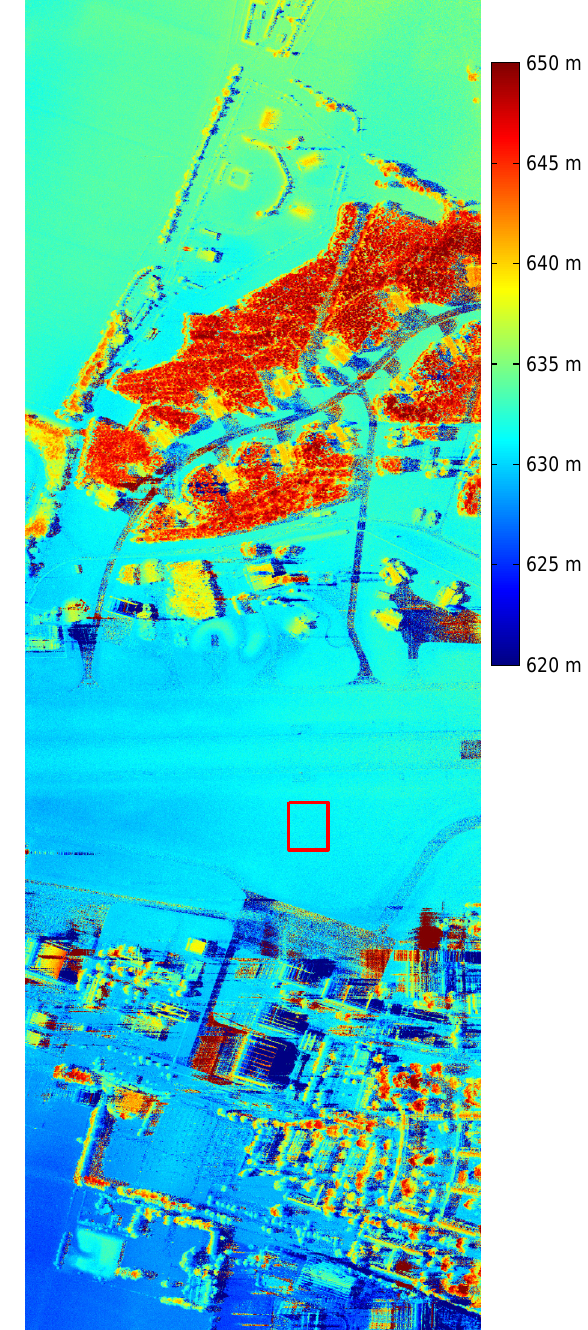
reference system 1992).